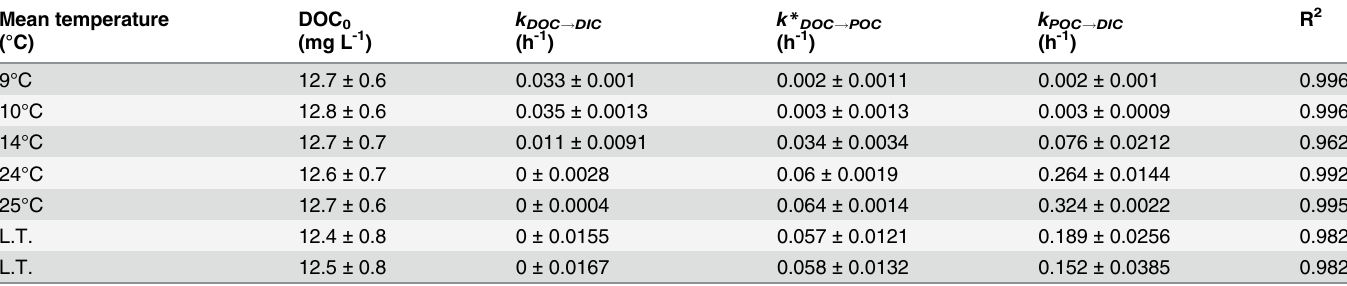
Table 2. Modeled initial concentrations, and individual transformation pathway rate constants at different temperatures ± standard errors. Mean